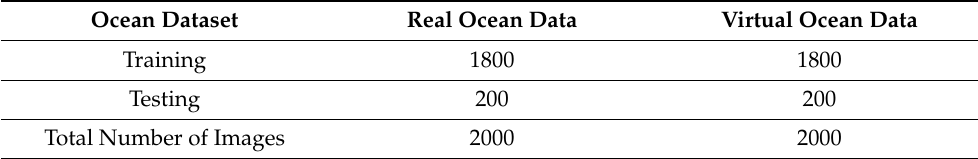
Table 2. Training data overview, including the distribution of images for training and